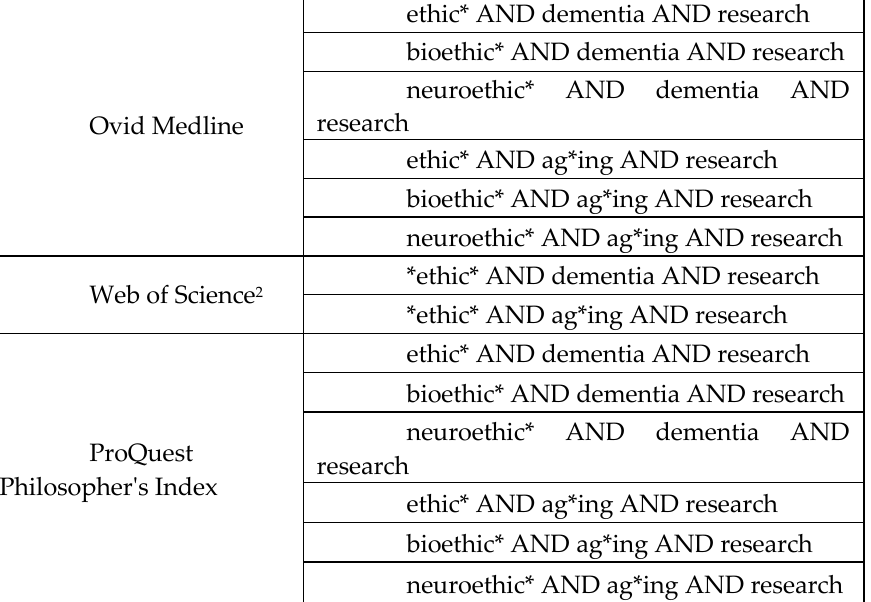
Table 1: Search Queries, October 17,